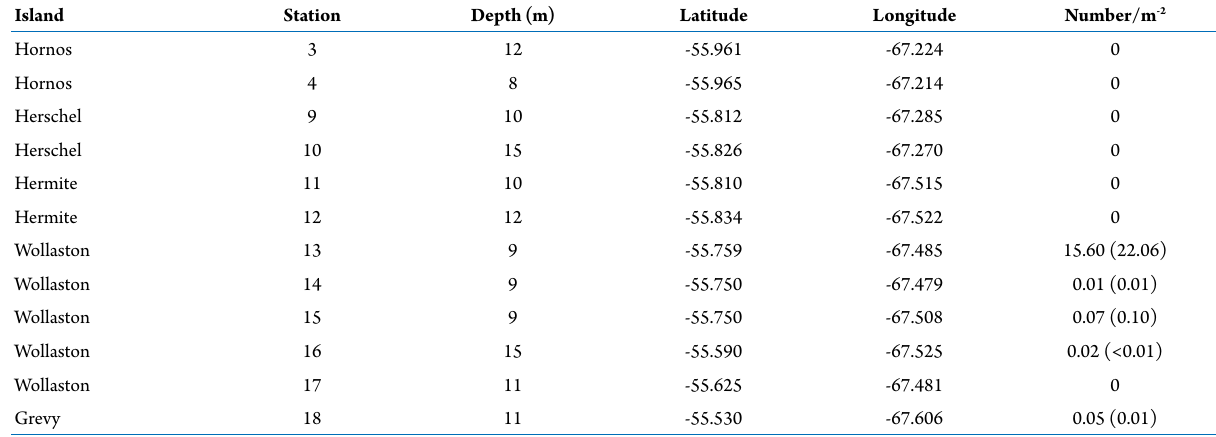
Table 1. Densities of Paralomis granulosa at islands and stations in the Cape Horn Archipelago, southern Chile. Values are means per station with one standard deviation of the mean in parentheses. Station numbers shown in Fig. 1. Island Station Depth